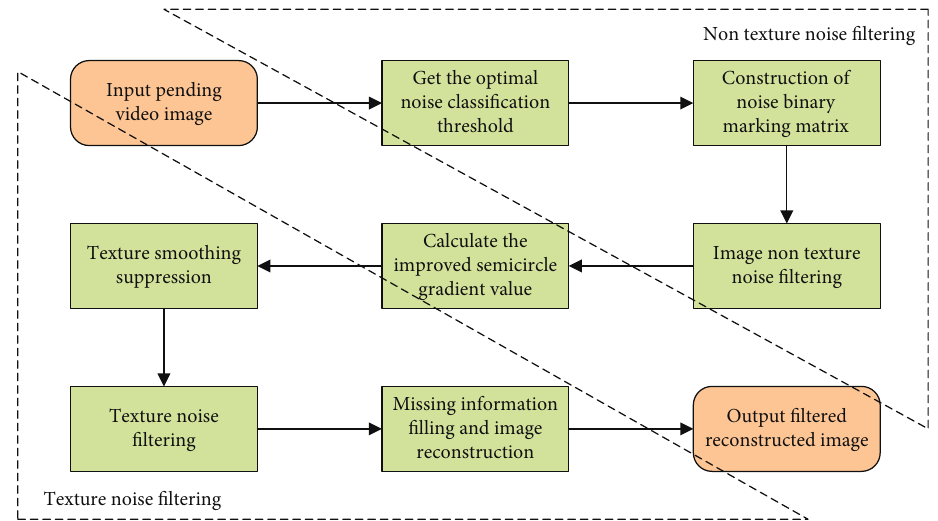
Figure 5: Calculation fl ow of local feature fi ltering model for dynamic underwater multiframe video images.